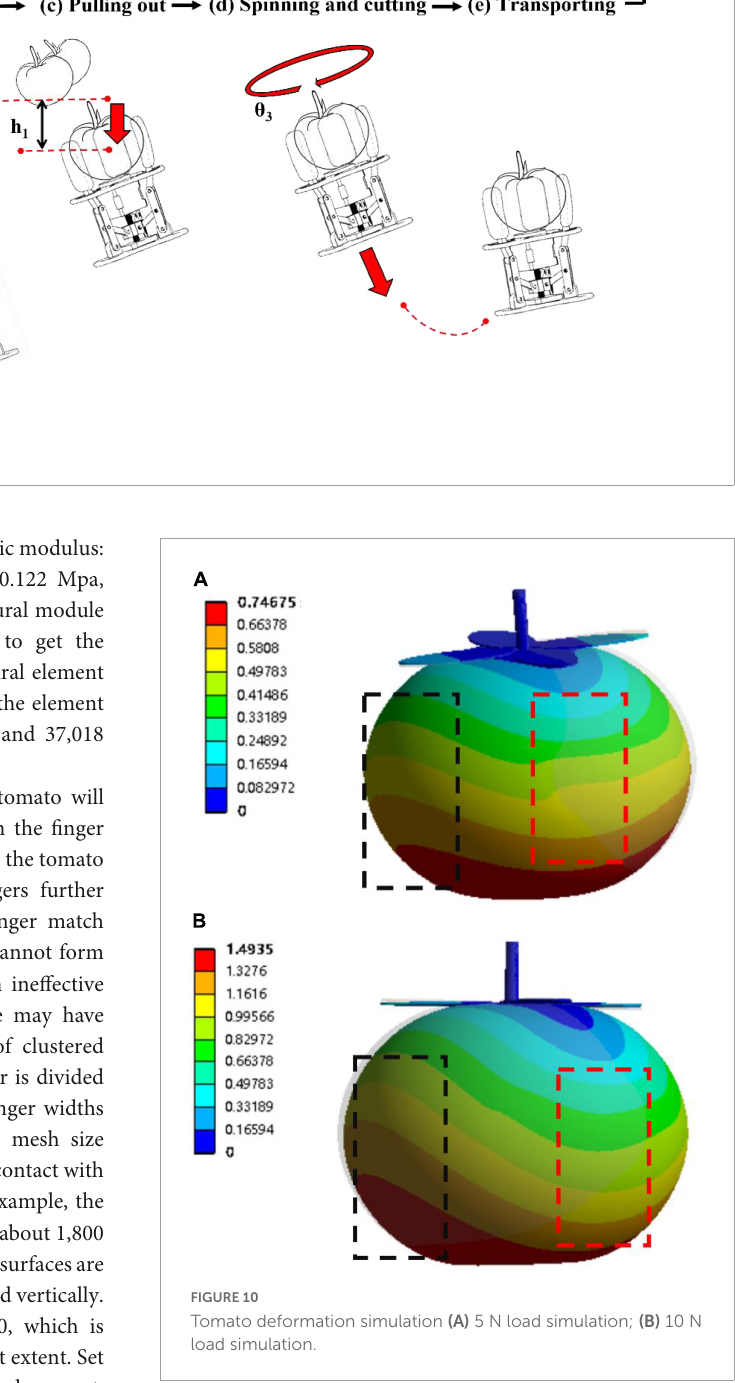
When the tomato is subjected to the load force exerted by the finger, as shown by the red dotted box area, the force-bearing part of the tomato deforms and displaces. At the same time,